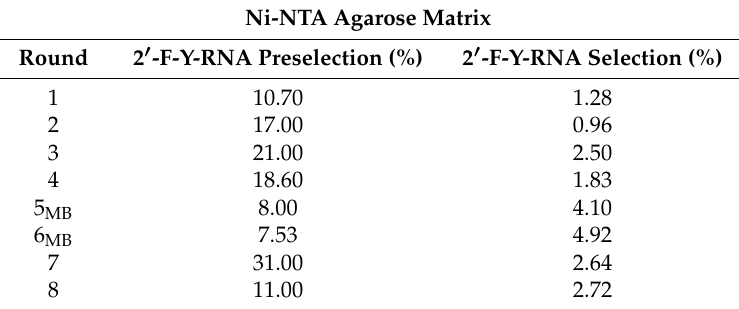
Table 2. The fractions (in %) of the 2 ′ -F-pyrimidine (Y)-modified RNA pool that remained bound to the matrix in the preselection step (central column) and that eluted after incubation with matrix-bound mLBP in each of the eight selection rounds (right column).